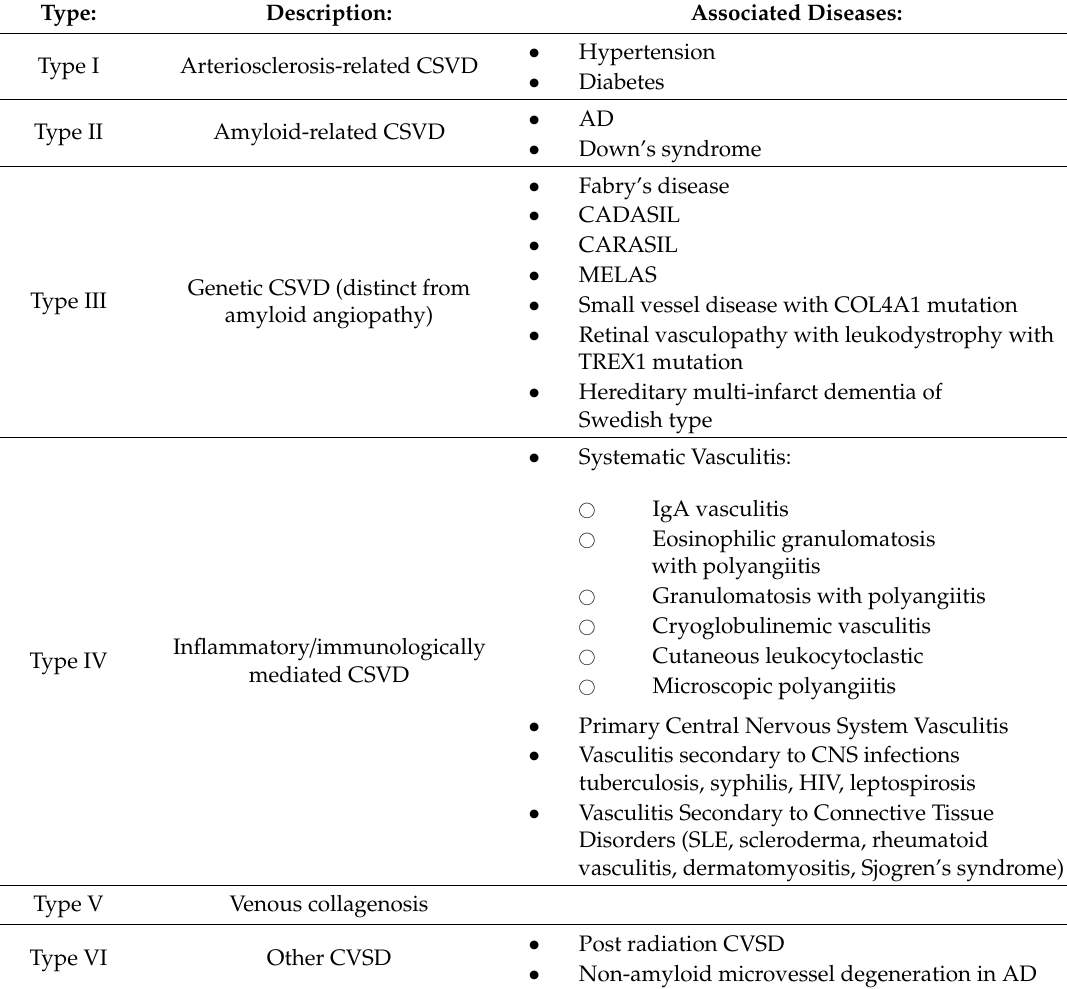
Table 1. Cerebralsmallvesseldisease(CVSD)classification. AD—Alzheimer’sdisease; CADASIL—cerebral autosomal dominant arteriopathy with subcortical ischemic stroke and leukoencephalopathy; CARASIL—cerebral autosomal recessive arteriopathy with subcortical ischemic and leukoencephalopathy; MELAS—mitochondrial encephalopathy with lactic acidosis and stroke-like episodes; CNS—central nervous system; SLE—systematic lupus erythematosus; HIV—human immunodeficiency